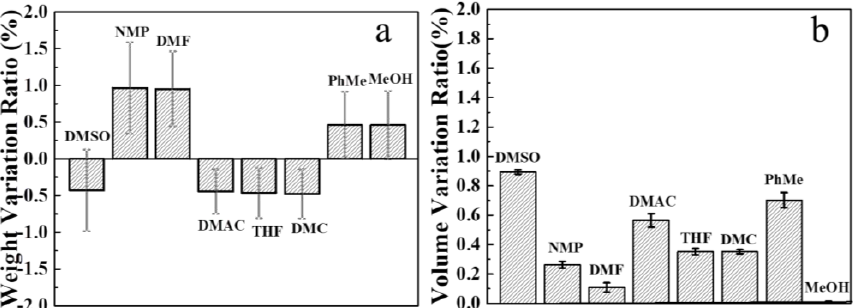
Figure 7. ( a ) Mass variation ratio and ( b ) swelling properties of ANF/HANF membranes (HANF content: 10 wt%) after soaking in different organic solvents for 15 days. content: 10 wt%) after soaking in different organic solvents for 15